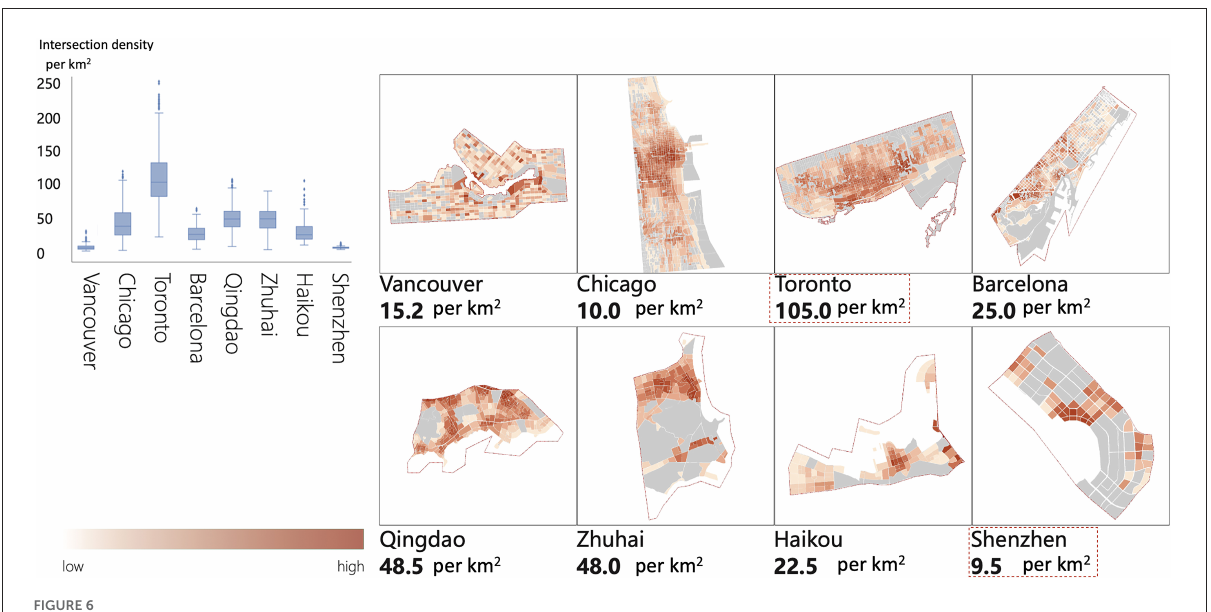
coastal zones are summarized in Table